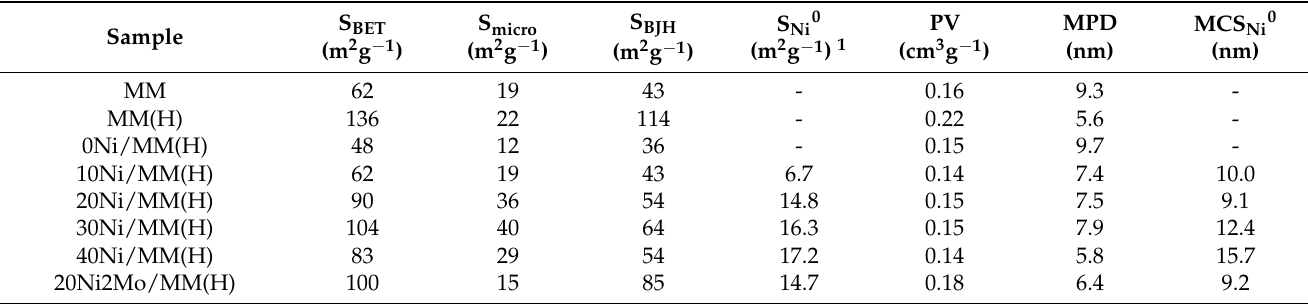
Table 1. Physicochemical characteristics of the supports and the